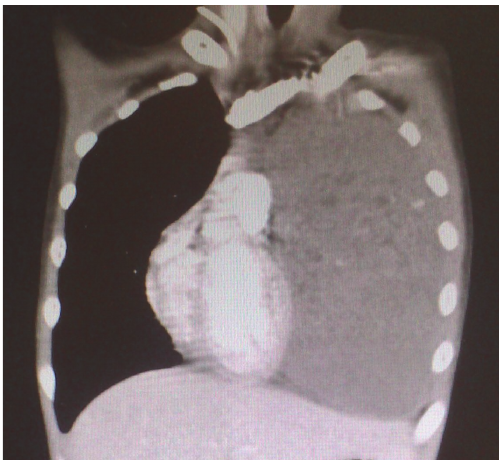
Figure 3: Coronal view of the CT scan showing that the mass occupies the whole of the left thoracic space with mediastinal shift to the right.